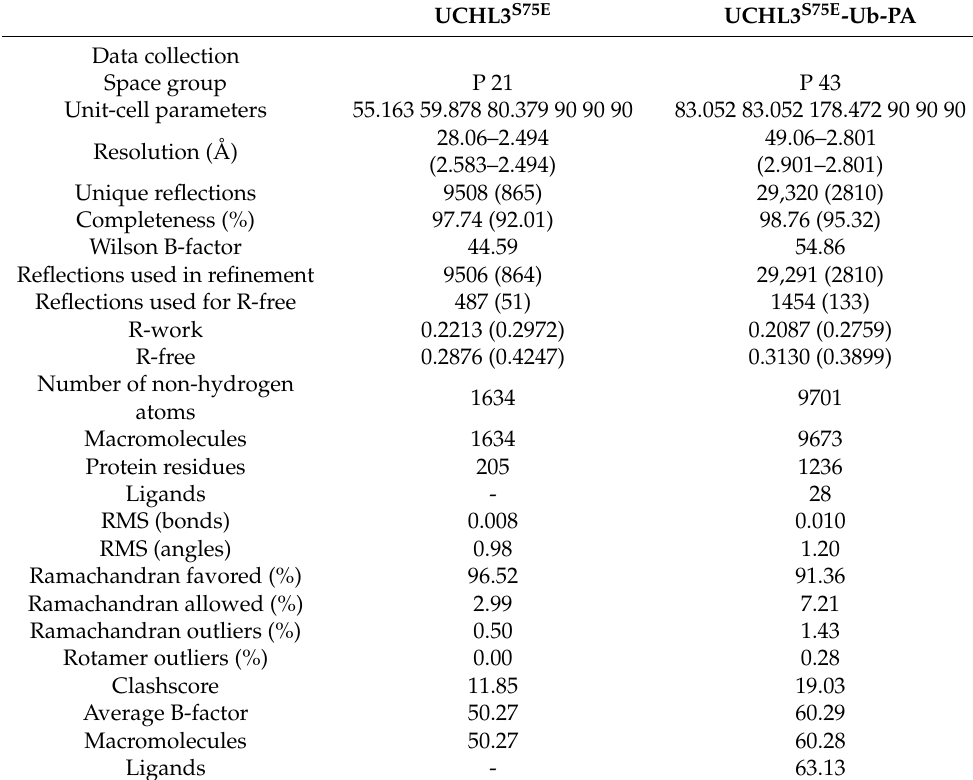
Figure 1. Crystal structure of ubiquitin C-terminal hydrolase-L3 (UCHL3) S75E . ( A ) Overview of the structure of UCHL3 S75E . ( B ) Structural comparison of UCHL3 S75E and UCHL3 WT ; the magnified part shows the structural changes of UCHL3 S75E and UCHL3 WT on α 3 helix. ( C ) Structural changes of amino acids near catalytic residue Cys95; magenta indicates the active site of Cys95. In all panels, UCHL3 S75E is in cyan, UCHL3 WT is in green, and amino acid residues 75 and 95 are in red and magenta, respectively. Table 1. Statistics for the highest-resolution shell are shown in